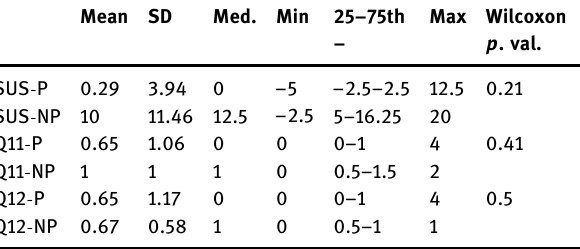
Table 12: Outcome di ff erences between the two repeated